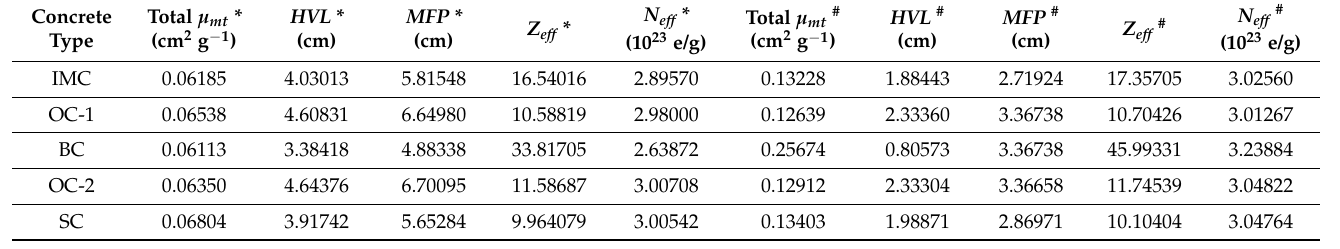
Table 4. The total mass attenuation coefficients ( µ mt ), the half value layer ( HVL ), the mean free path ( MFP ), the effective atomic number ( Zeff ), and the electron density ( Neff ) of the concrete types at 0.2 MeV # and 1 MeV * X-ray energies.